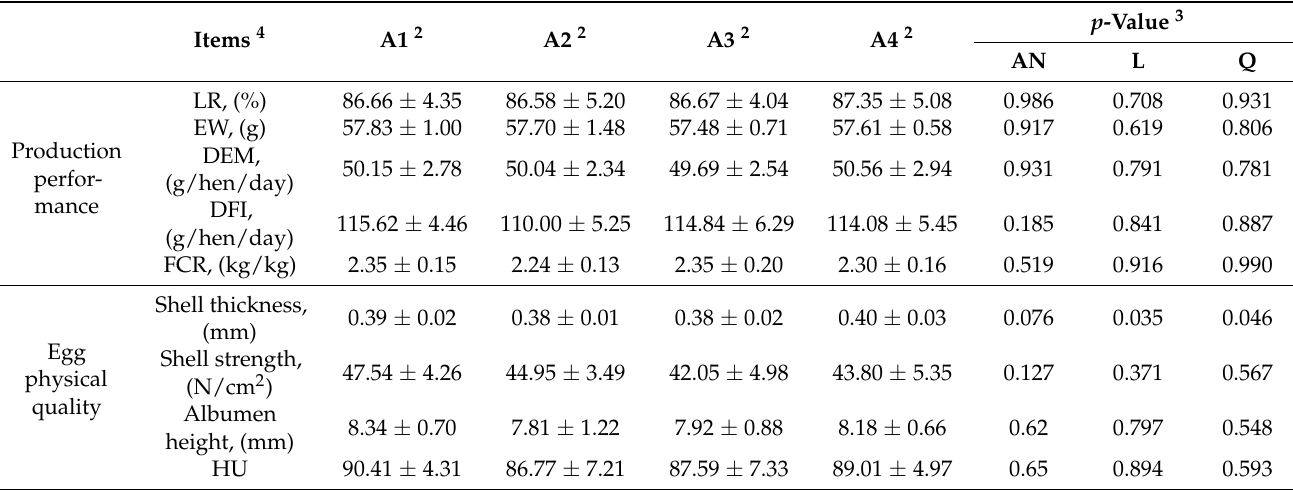
Table 2. Production performance of laying hens during trial and egg physical quality of laying hens on week 12 (mean ± STD 1 ).